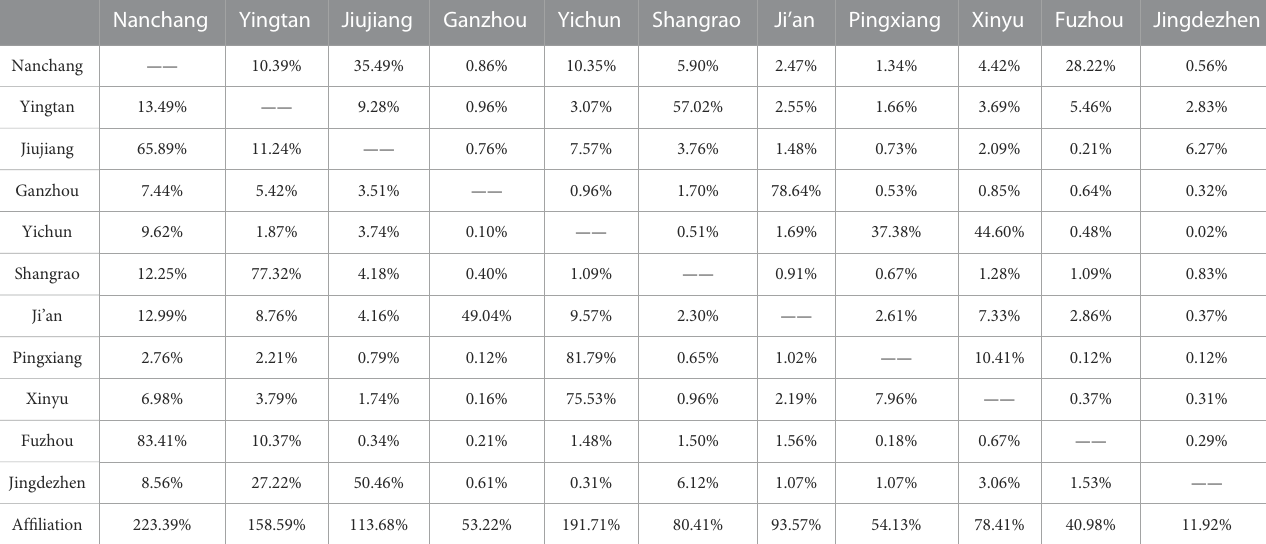
TABLE 10 Economic af fi liation of cities before opening high-speed